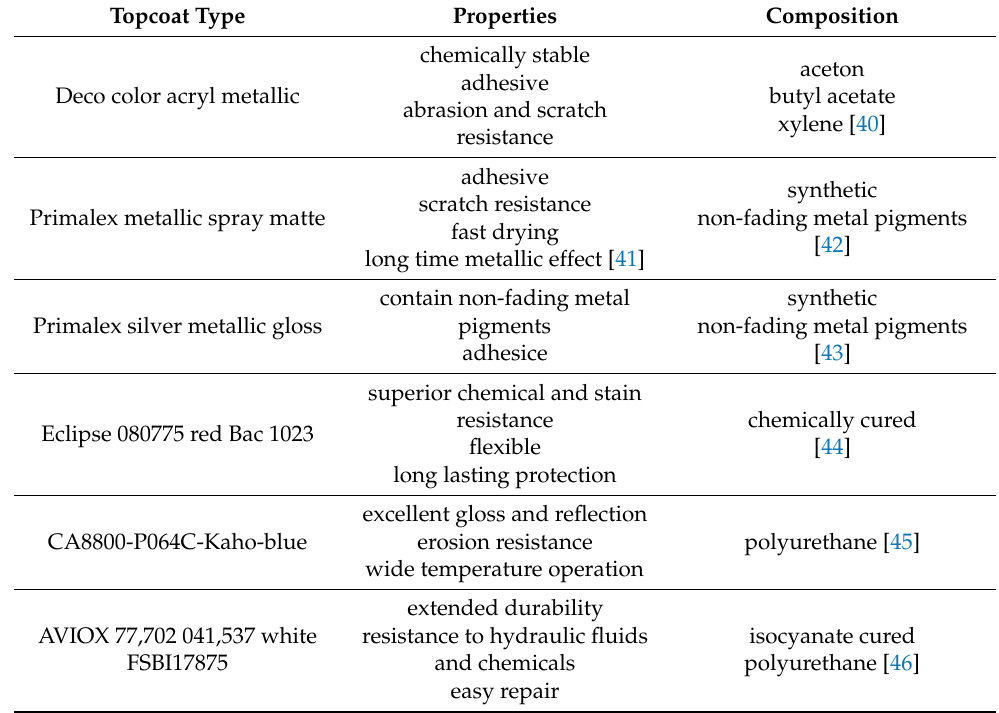
Table 2. Description of topcoats.